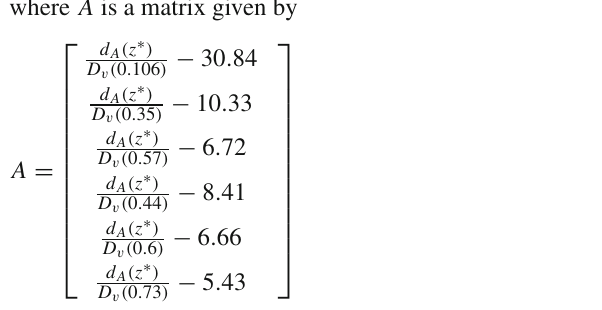
H ( z ) + SNeIa and H ( z ) + SNeIa + BAO , respectively. The dark shaded region shows the 1 σ error, light shaded region shows the 2 σ error and ultra light shaded region shows the 3 σ error. Black dots represent the best fit values of the model parameter α and the values of H 0 in both